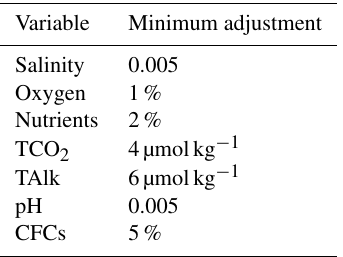
Table 2. Initial minimum adjustment limits introduced by CARINA and subsequently used for PACIFICA and